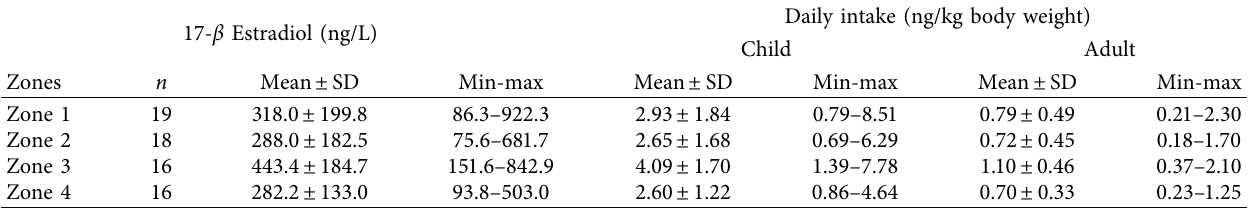
Table 3: Milk 17 β -estradiol level and its daily intake in the different regions of Hamadan, Iran.